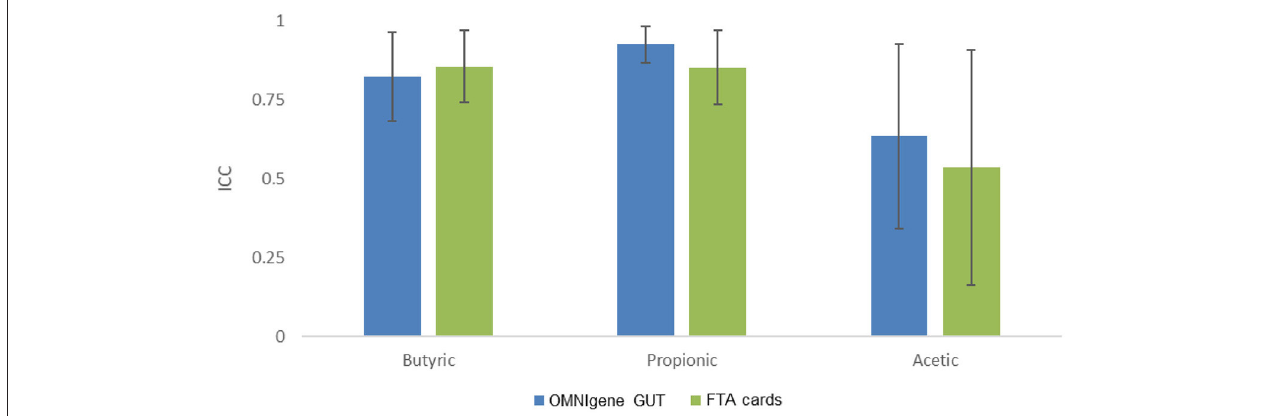
FIGURE 4 | The concordance of fecal collection methods compared with the gold standard immediate freezing: intraclass correlation coefficients (ICC) and 95% CI for the three predominant SCFAs.